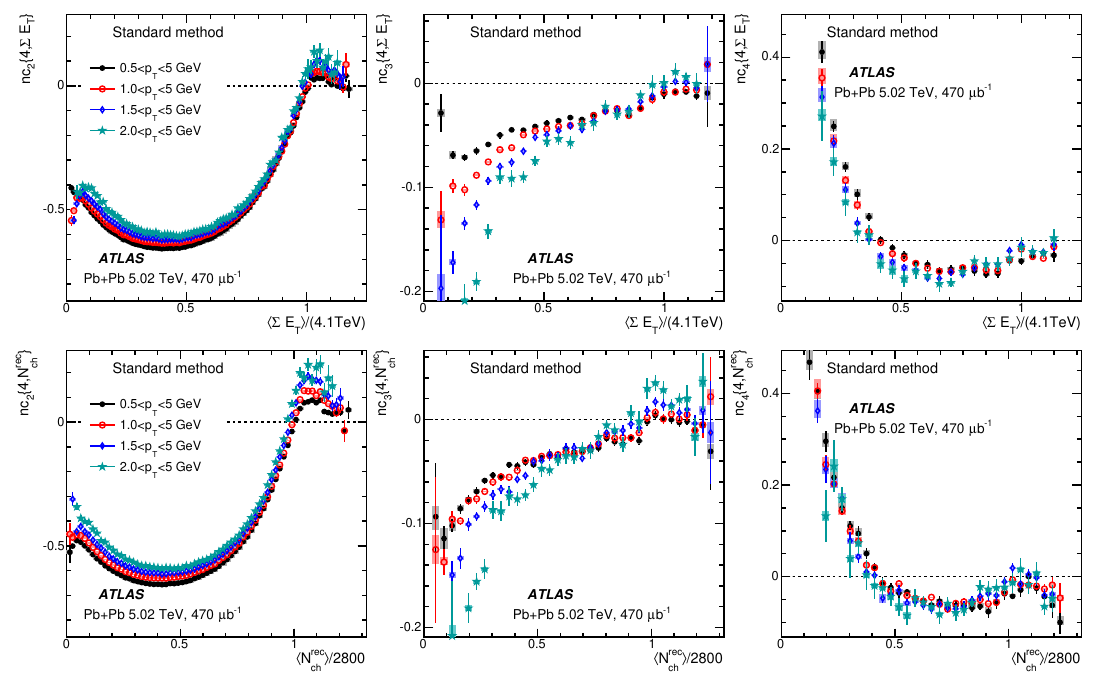
Figure 15 . The normalized four-particle cumulants nc n f 4 ; (cid:6) E T g as a function of h (cid:6) E T i (top row) and nc n f 4 ; N rec g as a function of h N rec i (bottom row) for n = 2 (left panel), n = 3 (middle panel), ch ch and n = 4 (right panel) for four p T ranges. The error bars and shaded boxes represent the statistical and systematic uncertainties, respectively. Zero is indicated by a dotted line.